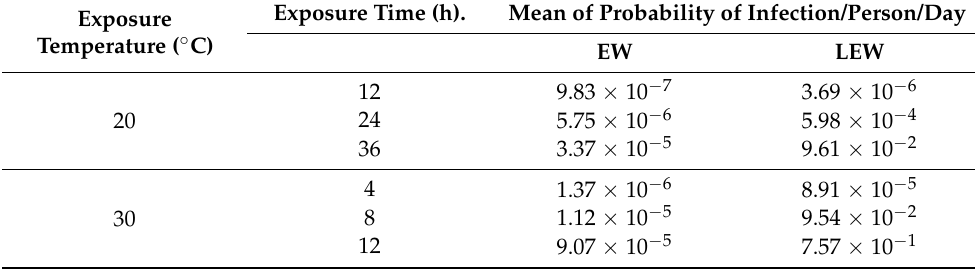
Table 4. Comparison of the probabilities of risk in LEW and EW at 20 and 30 ◦ C.